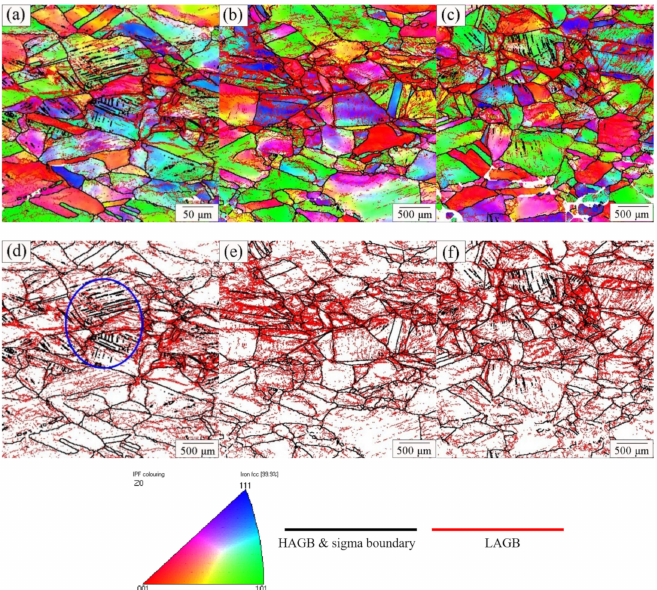
Figure 7. EBSD grain boundary maps of the specimens fabricated by the tensile deformation ε t = 0.30: IPF maps ( a – c ) and distribution maps of grain boundary ( d – f ), 12Cr–CN ( a , d ), 19Cr–0.7N ( b , e ), 19CrSi–0.7N ( c , f